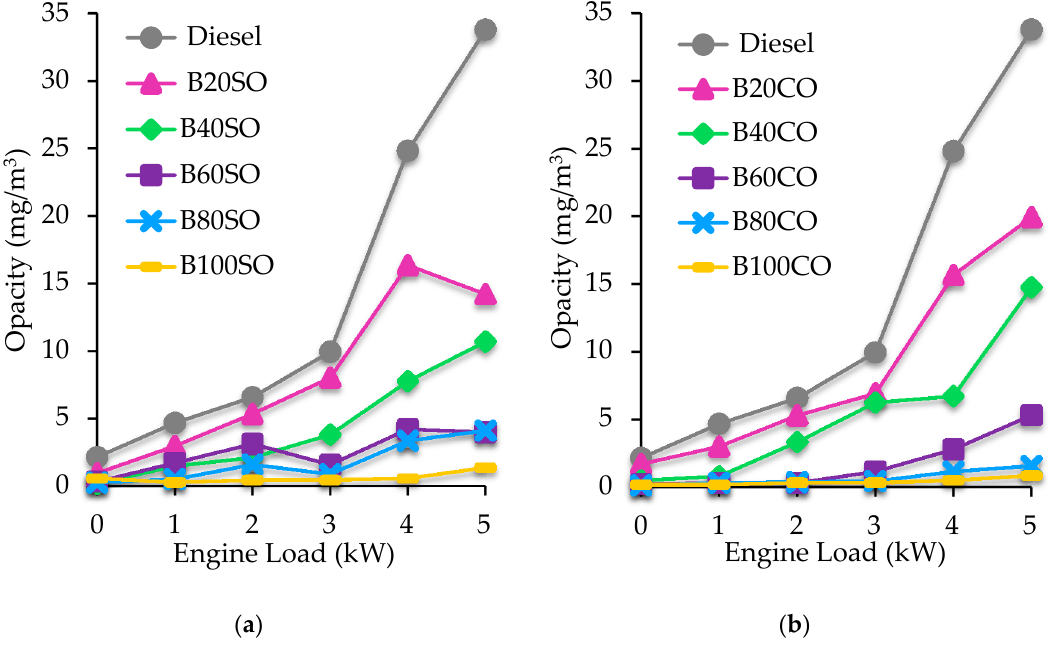
Figure 4. Opacity values (mg/m 3 ) at engine loads from 0 kW to 5 kW, for the fuel blends: ( a ) DEC/SO and D/DEC/SO; ( b ) DEC/CO and D/DEC/CO.